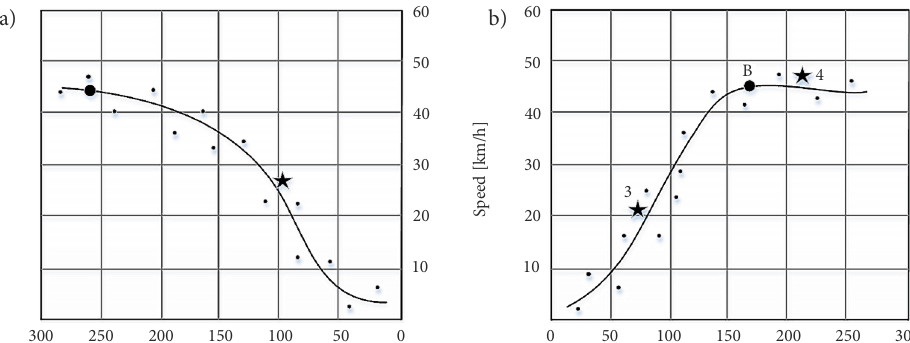
Figure 3. Deceleration (a) and acceleration (b) patterns in the spatial